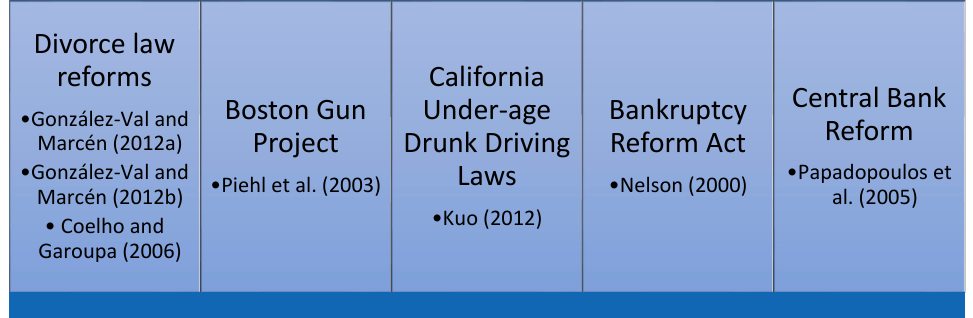
Figure 1. Literature: Time series analysis and legal reforms (González-Val and Marcén 2012a, 2012b; Coelho and Garoupa 2006; Piehl et al. 2003; Kuo 2012; Nelson 2000; Papadopoulos et al. 2005).